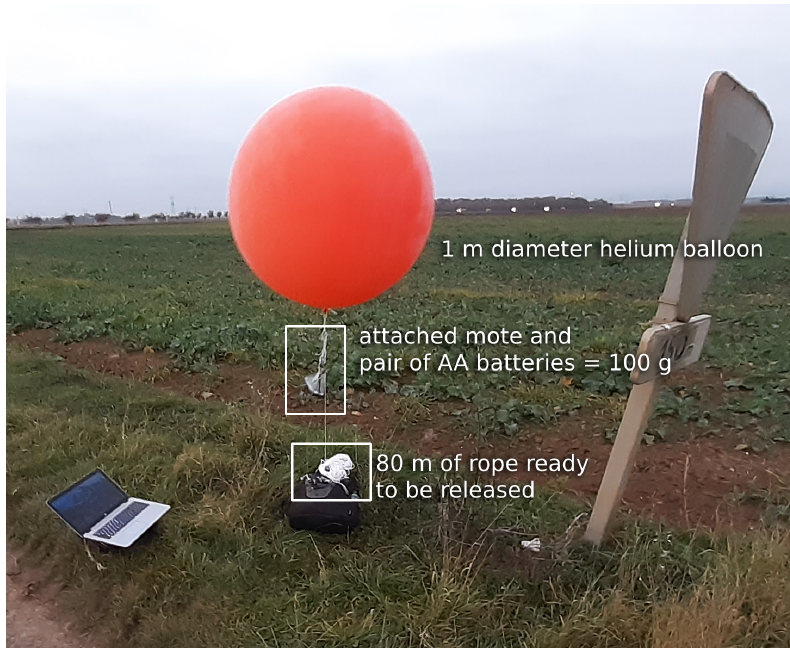
Figure 10. An OpenMote Bwas attached to a helium balloon.